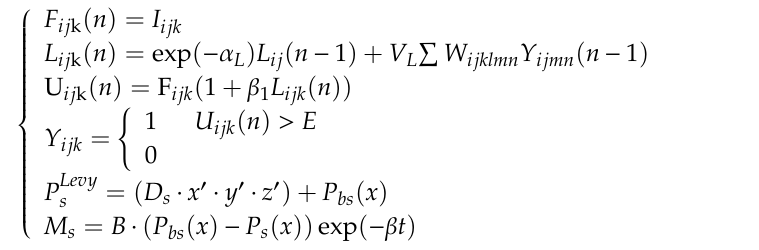
Figure 6. Remote Sens. 2019 , 11 , x FOR PEER REVIEW